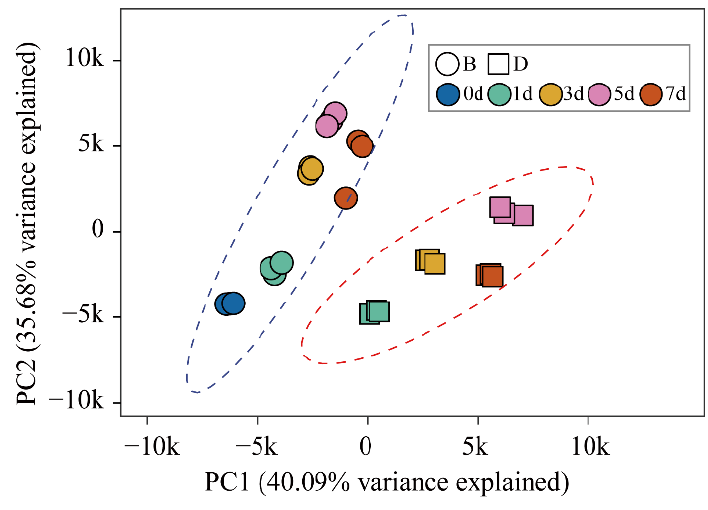
Figure 2. Principal component analysis (PCA) plots showing repeatability and heterogeneity of sequencing samples.